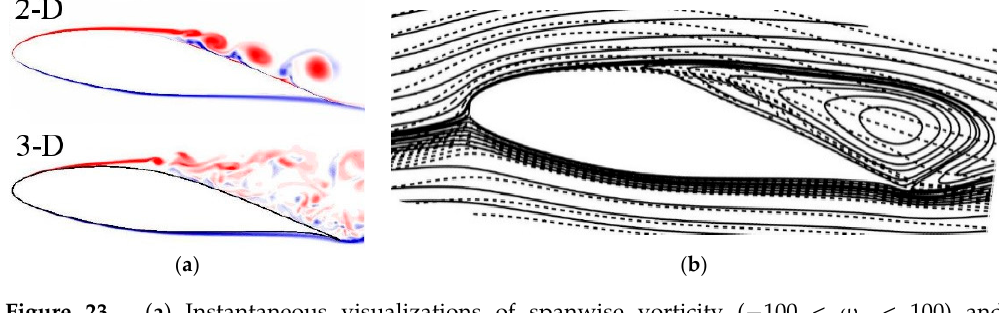
Figure 23. ( a ) Instantaneous visualizations of spanwise vorticity ( − 100 < ω z < 100) and ( b ) streamfunction isocontours computed from temporal averages (2D: dashed lines, 3D: solid lines, spanwise average) for Re = 64,200 and α = 8.64 degrees (Reprinted from [32]).